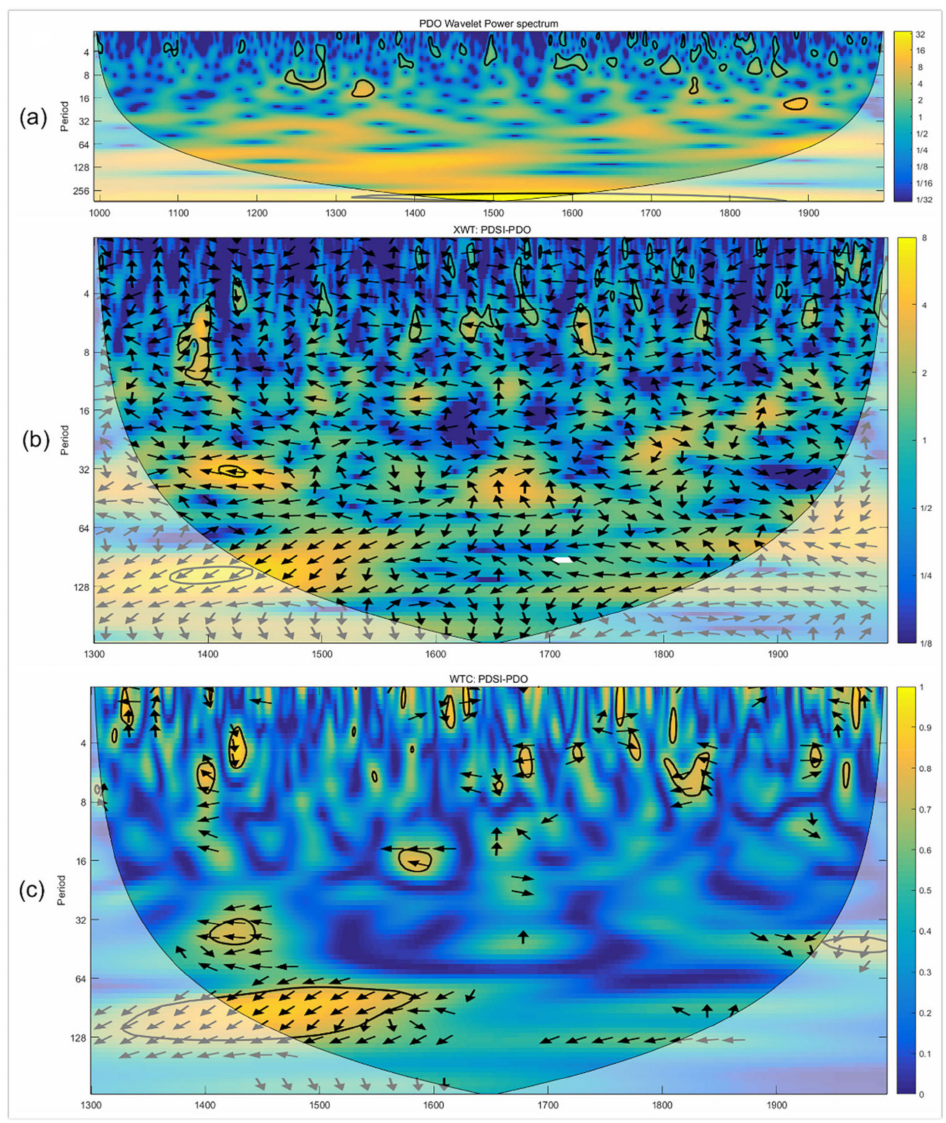
Figure 9. Results of ( a ) wavelet power spectrum, ( b ) cross wavelet (XWT), and ( c ) wavelet coherence (WTC) between the PDSI and PDO series. Graphic illustration can refer to Figures 6 and